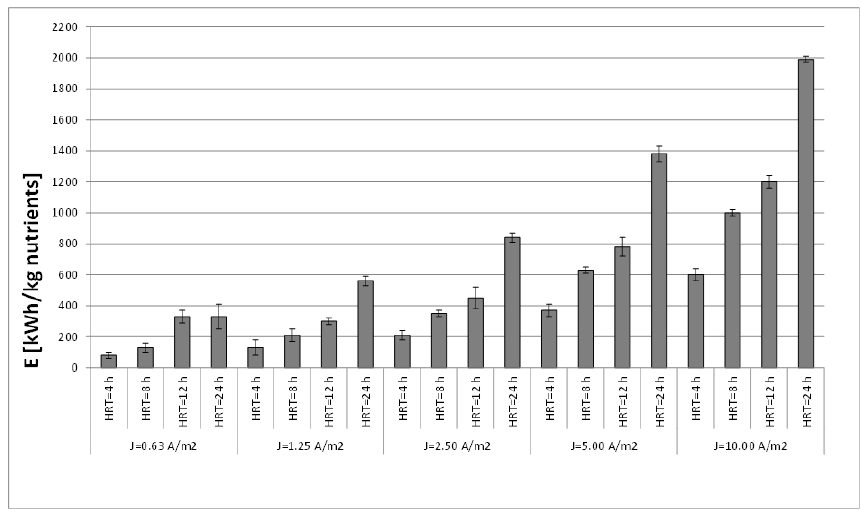
Figure 4. Electric energy consumption per unit of removed nutrients load in an aerobic REBDC.